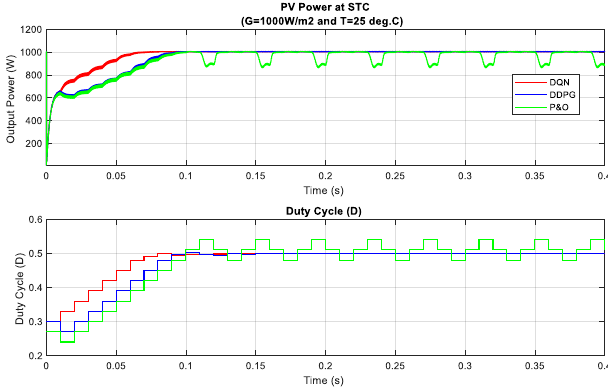
Figure 6. PV power and duty cycle at standard condition.